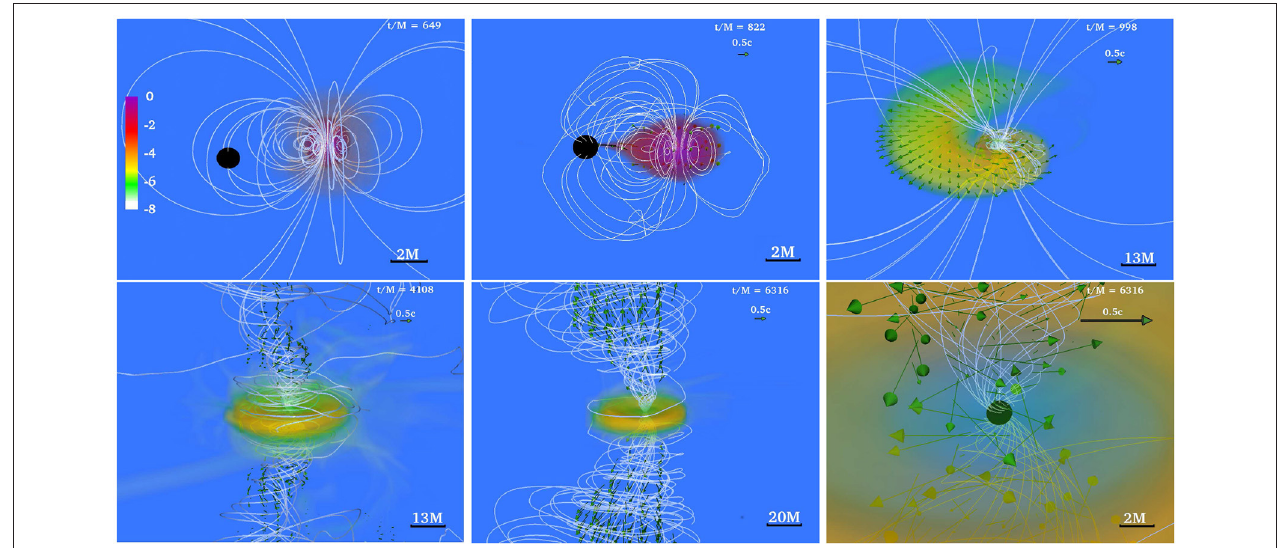
FIGURE 3 | NS rest-mass density ρ 0 normalized to its initial maximum value ρ 0,max = 8.92 × 10 14 (1.4 M ⊙ / M NS ) 2 g / cm 3 (log scale) at selected times for a BHNS with mass ratio q = 3. The initial BH spin is a BH / M BH = 0.75 and the NS is an irrotational Ŵ = 2 polytrope. Arrows indicate fluid velocities and white lines the magnetic field lines. Bottom panel shows the system after an incipient jet is launched. Here M = 2.5 × 10 − 2 ( M NS / 1.4 M ⊙ )ms = 7.58(M NS / 1.4M ⊙ )km (from Paschalidis et al.,